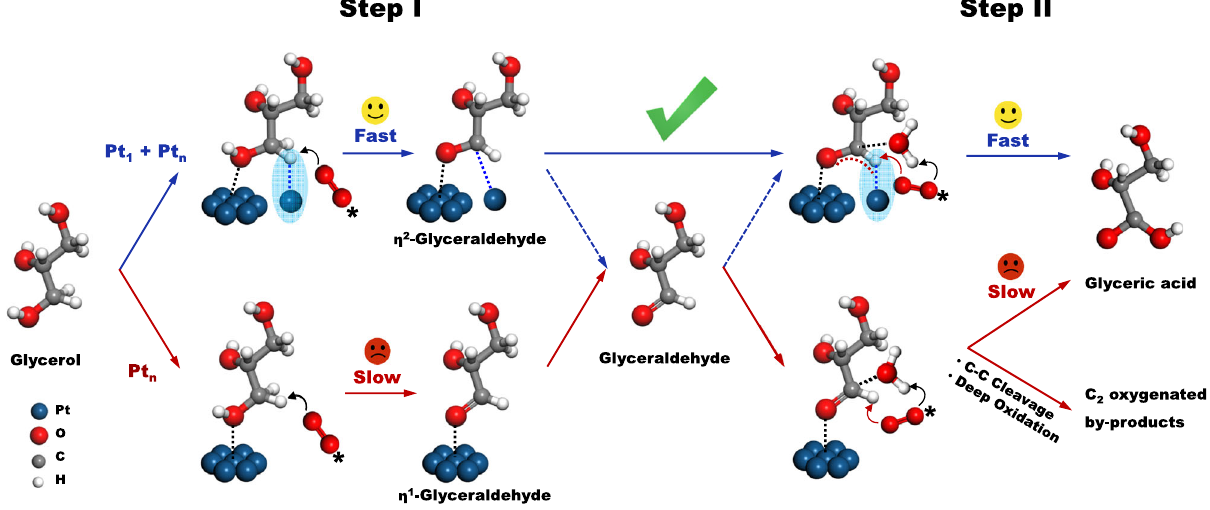
Fig. 1 | Proposed cascade synergistic catalysis strategy by atomic Pt 1 and clusterPt n